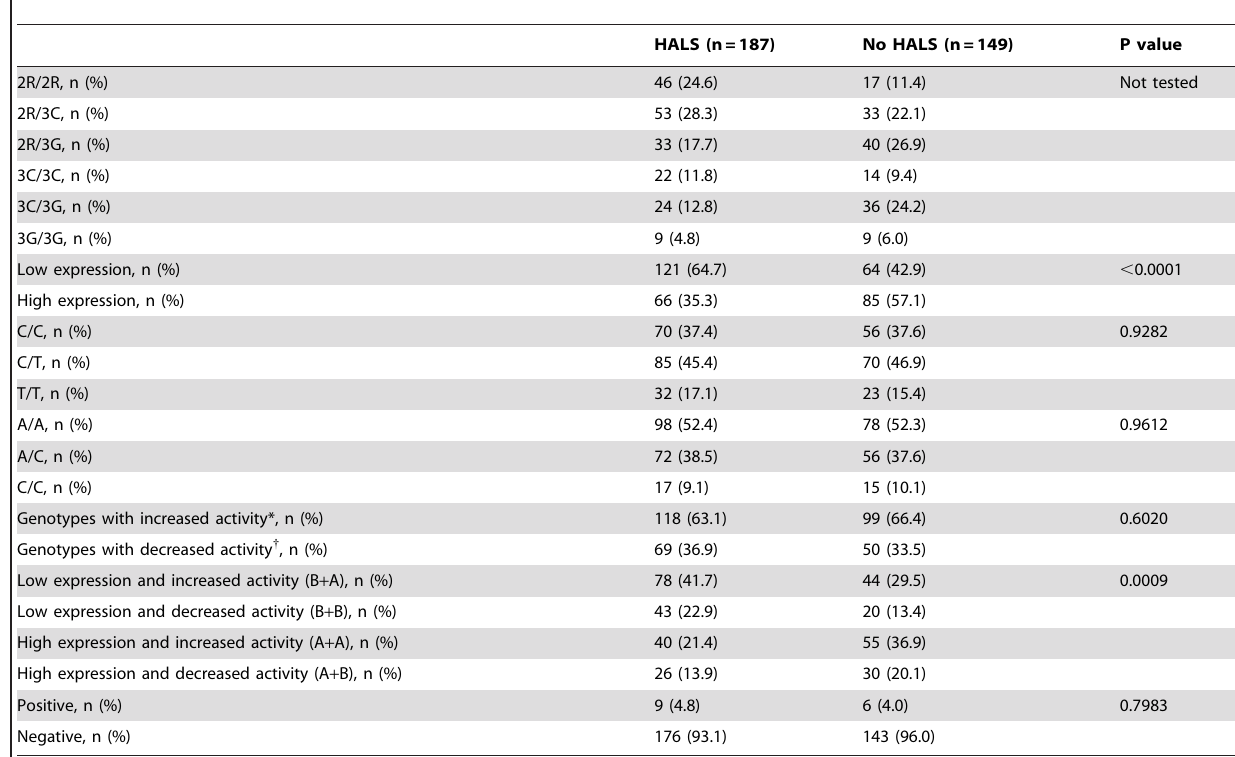
Table 4. Gene polymorphisms associated with the presence of HALS in d4T-exposed patients.